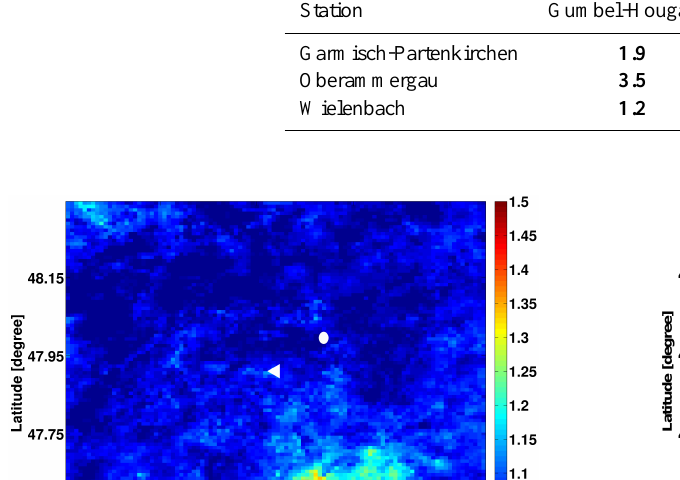
Table 6. Value of the K-function times 10 4 for radar/gauge pairs at the stations Garmisch-Partenkirchen, Oberammergau and Wielenbach for three Archimedean copulas (Gumbel-Hougaard, Frank, Clayton). Smallest values indicate the best fit (bold).